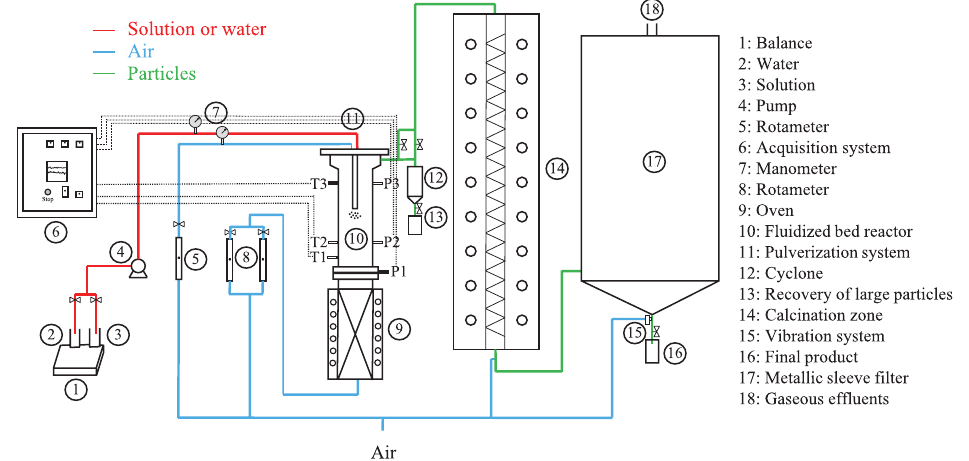
Fig. 1 Schematic of the